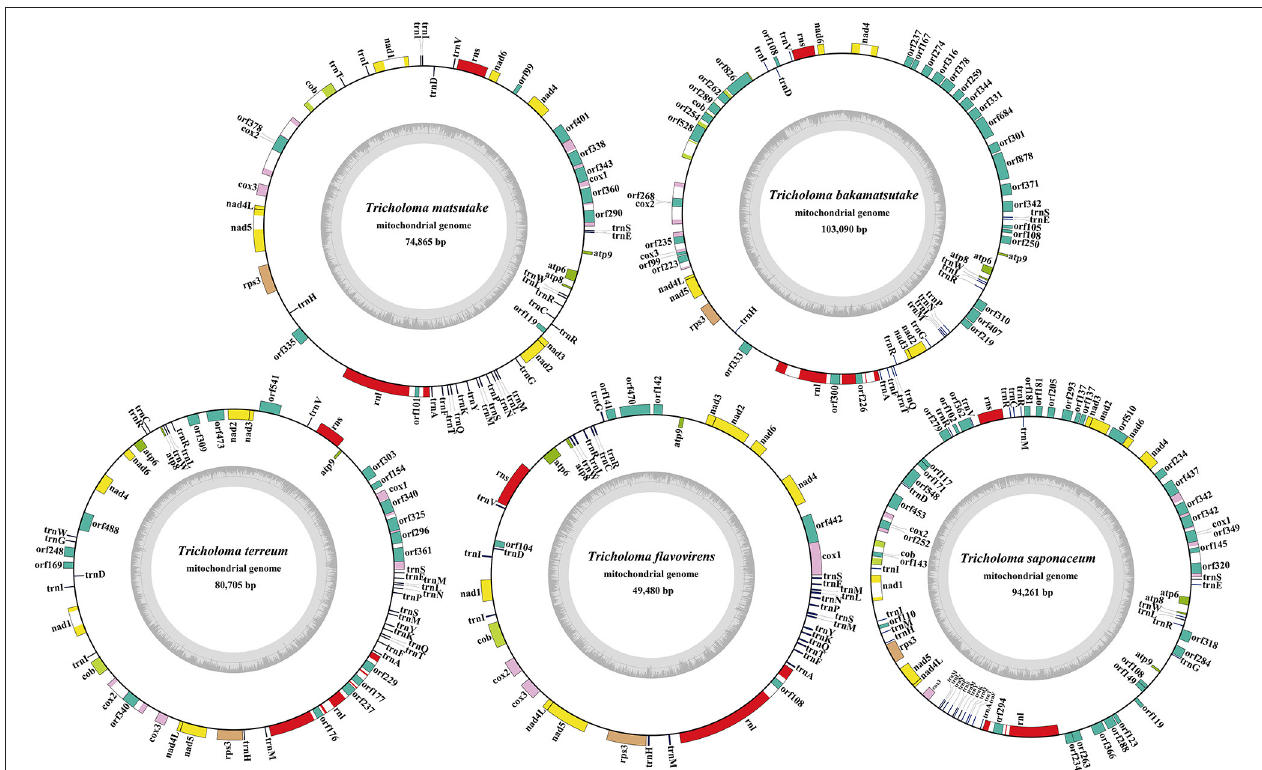
FIGURE 1 | Circular maps of the mitochondrial genomes of five Tricholoma species. Genes are represented by different-colored blocks. Colored blocks outside each ring indicate that the genes are on the direct strand, while colored blocks within the ring indicate that the genes are located on the reverse strand.